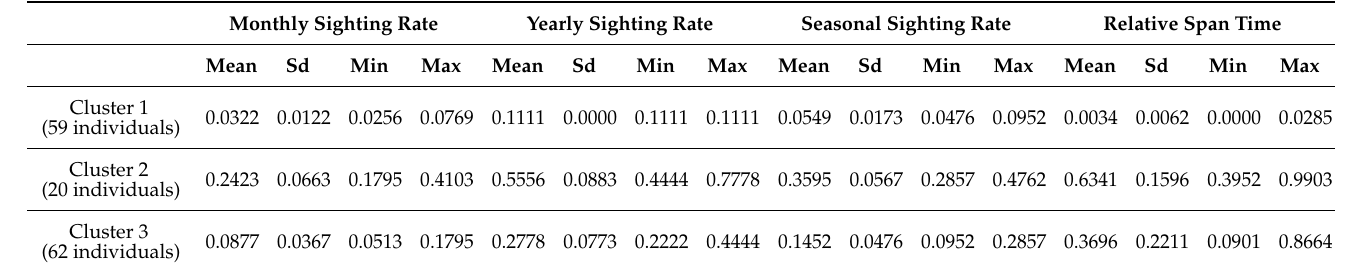
Figure 3. Elbow method plot used in determining the number of clusters in a data set. The elbow of the curve is used as a cutoff point of the dendrogram. Table 2. Mean, standard deviation (Sd), minimum (Min) and maximum (Max) values of the monthly, seasonal, annual sighting rate and the relative span time index estimated for the individuals of bottlenose dolphin included in the agglomerative hierarchical cluster